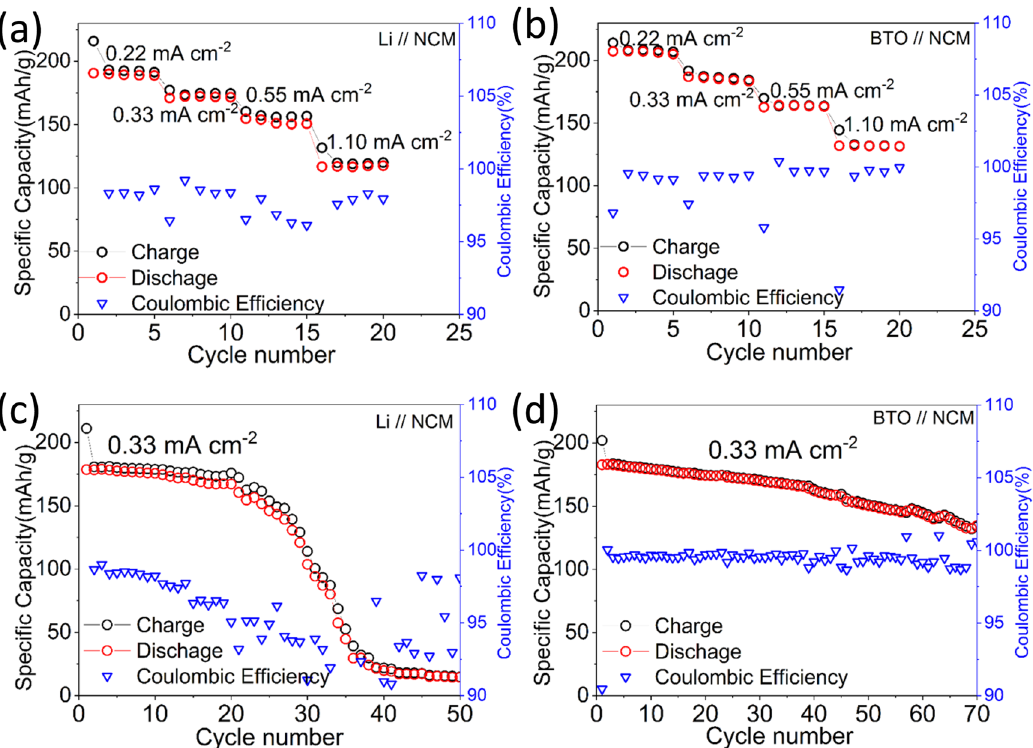
Fig. 5 Electrochemical performances and coulombic ef fi ciency of Li metal and BTO scaffold when paired with NCM positive electrode. a , b Rate test from 0.22 mA cm − 2 to 1.10 mA cm − 2 . c , d Cycling performance at 0.33 mA cm − 2 .